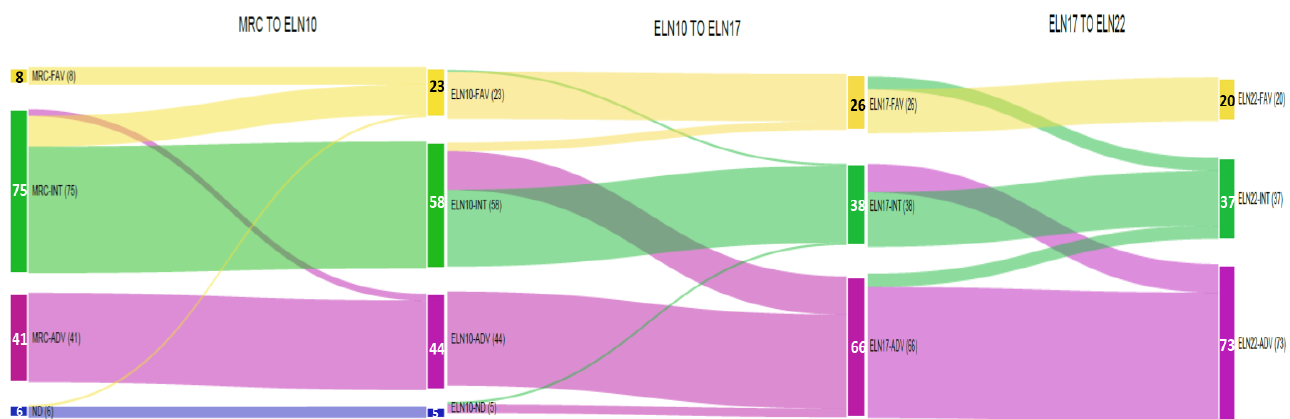
Figure 3. Sankey diagram showing evolving re-classifications from MRC to ELN2022 stratification. Orange: favorable risk; green: intermediate risk; violet: adverse risk; blue: no classified.